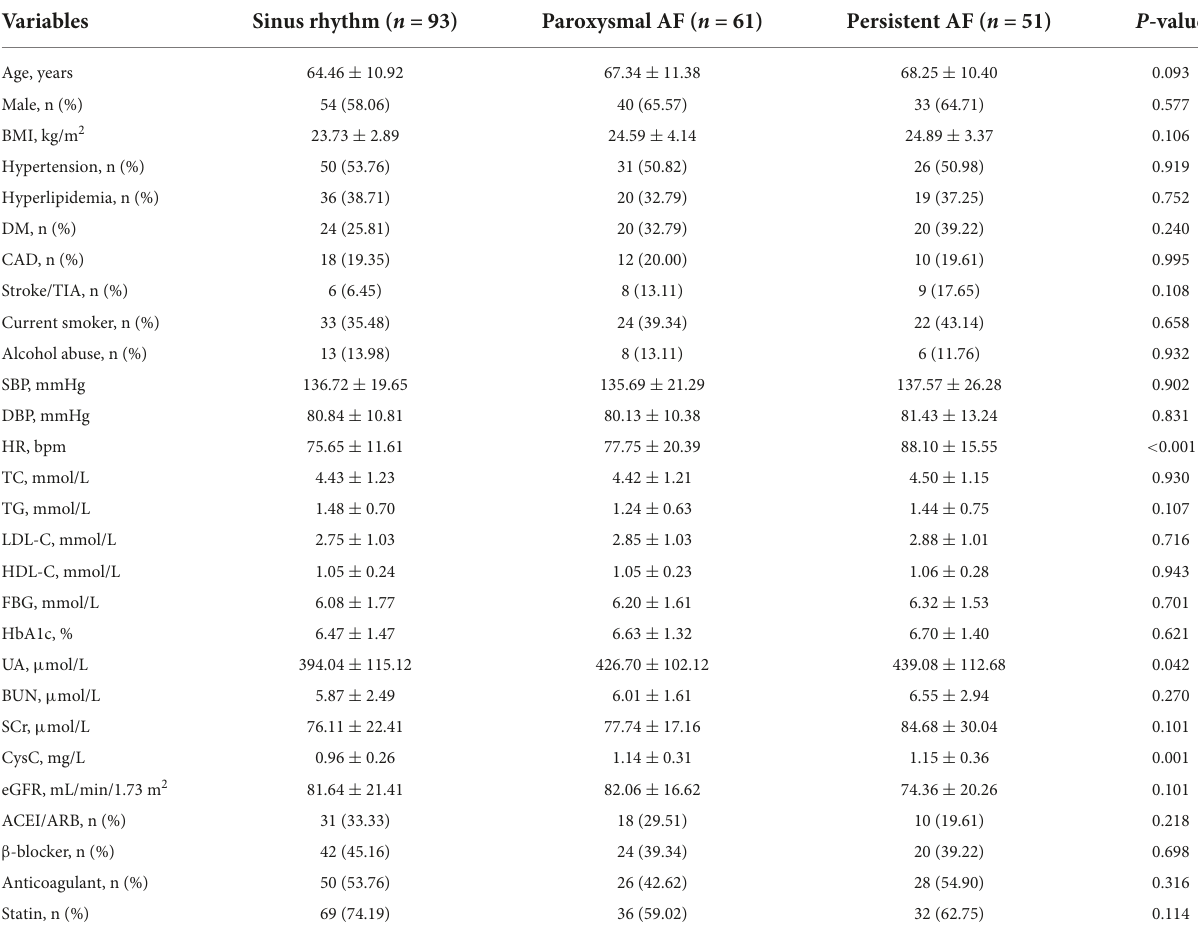
TABLE 1 Baseline characteristics of participants.